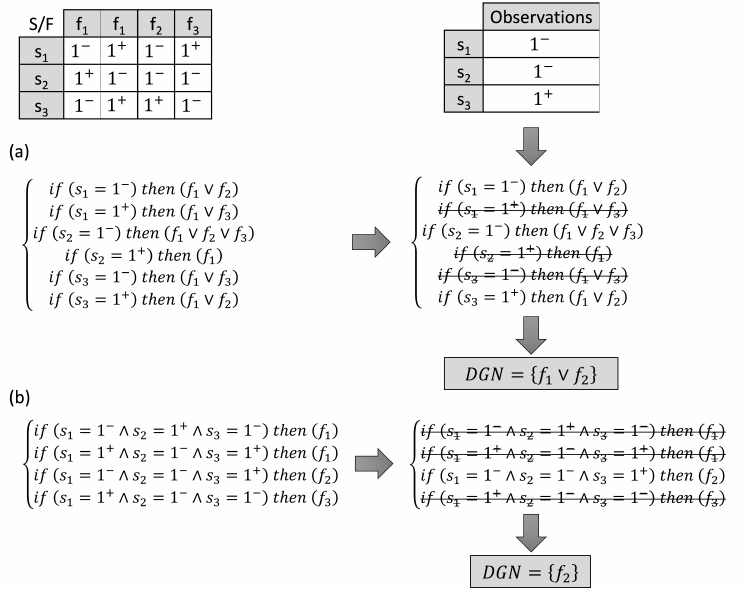
Figure 1. Reasoning based on rules corresponding to: ( a ) rows or ( b ) columns (fault signatures) of the FIS